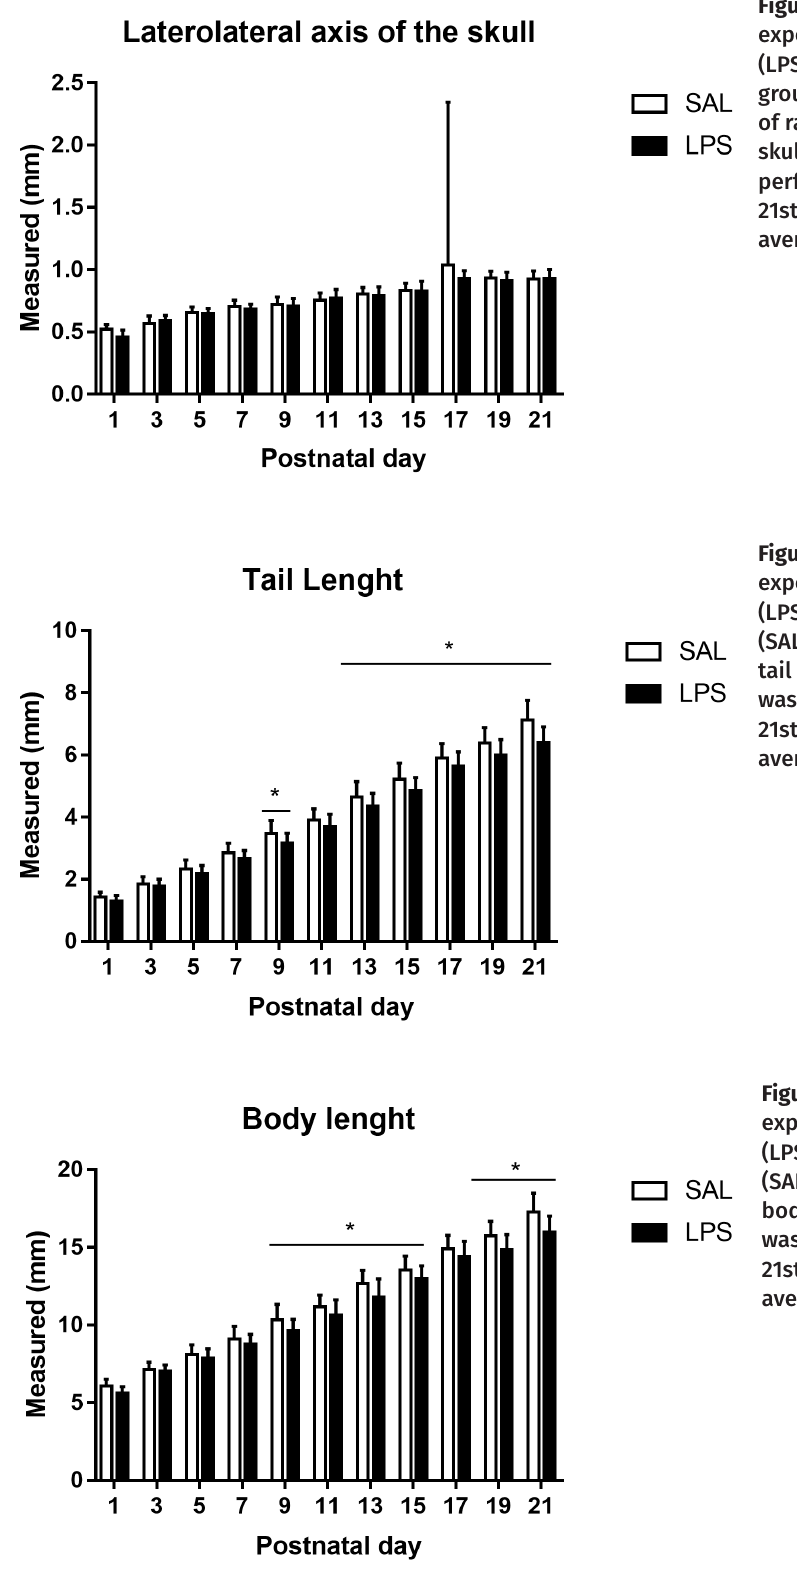
Figure 2. Effects of prenatal exposure to lipopolysaccharide (LPS), compared to the control group (SAL), on the development of rats: laterolateral axis of the skull (n=120). The evaluation was performed from the 1st to the 21st day of life. Data presented on average ± S.D. *p < 0.05.